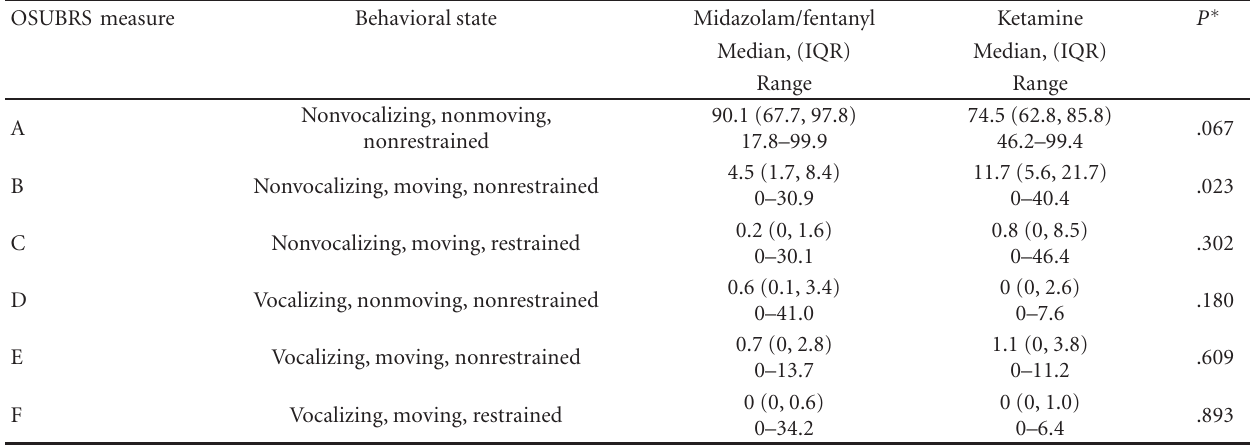
Table 2: Median percent time spent by patients receiving either midazolam/fentanyl or ketamine sedation in each behavioral state ( N = 37).